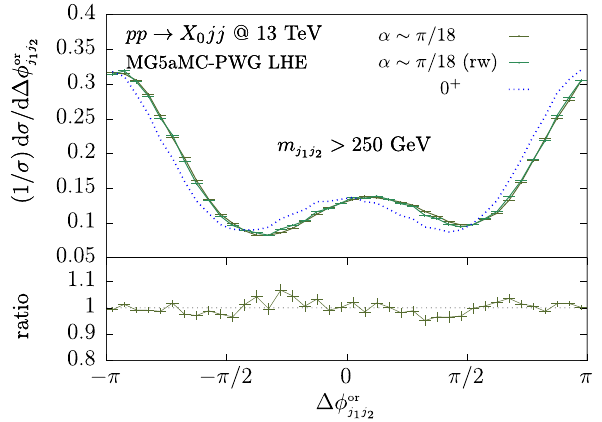
Fig. 12 Same as Fig. 10 but for the reweighting of the scalar sample to the CP scenario defined by cos α = 0 . 985